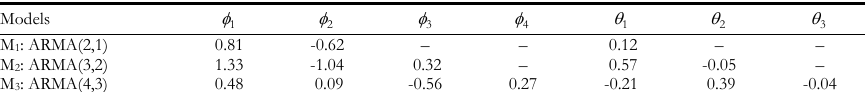
ARMA (p,q) models of increasing